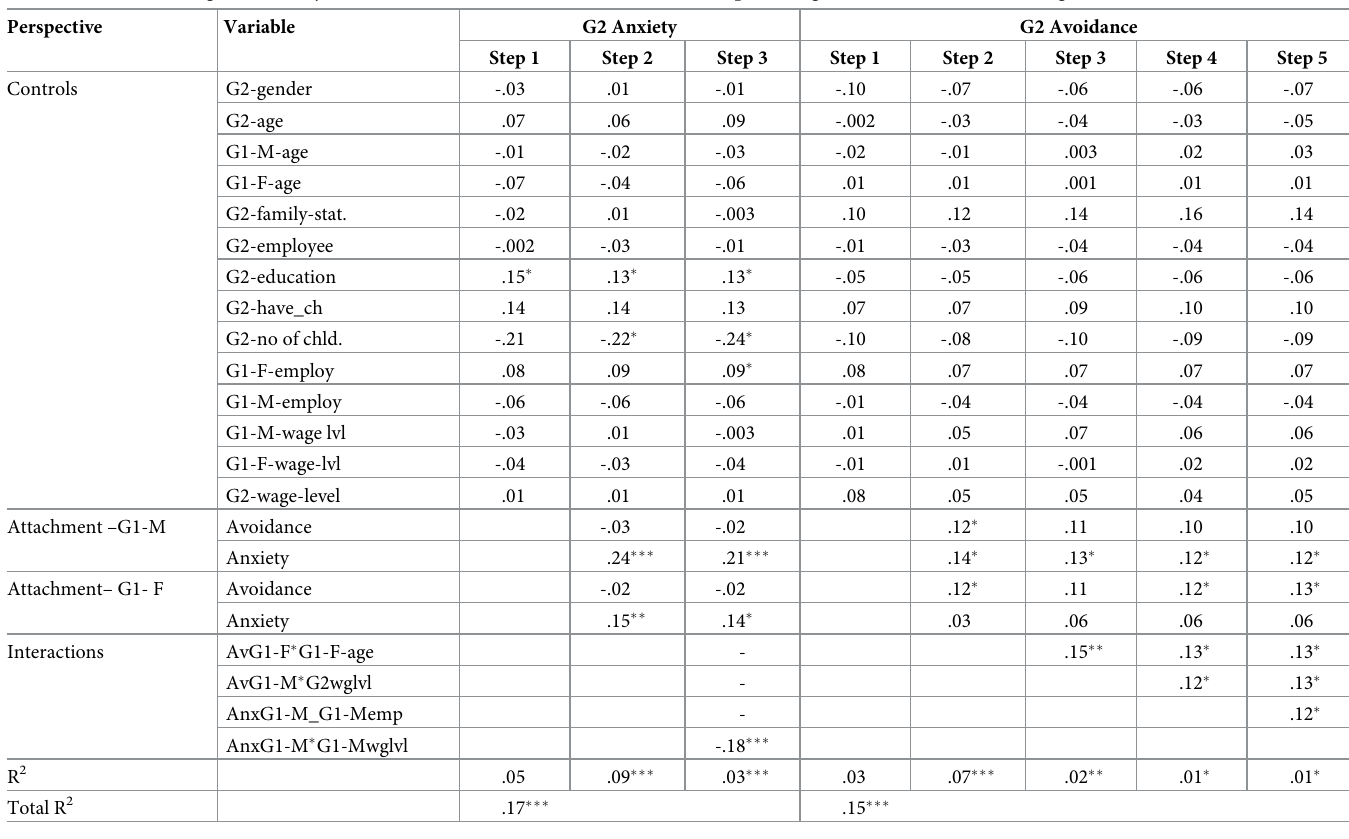
Table 2. Hierarchical regression analysis of attachment orientations and interactions in predicting G2 attachment orientation (general measure).